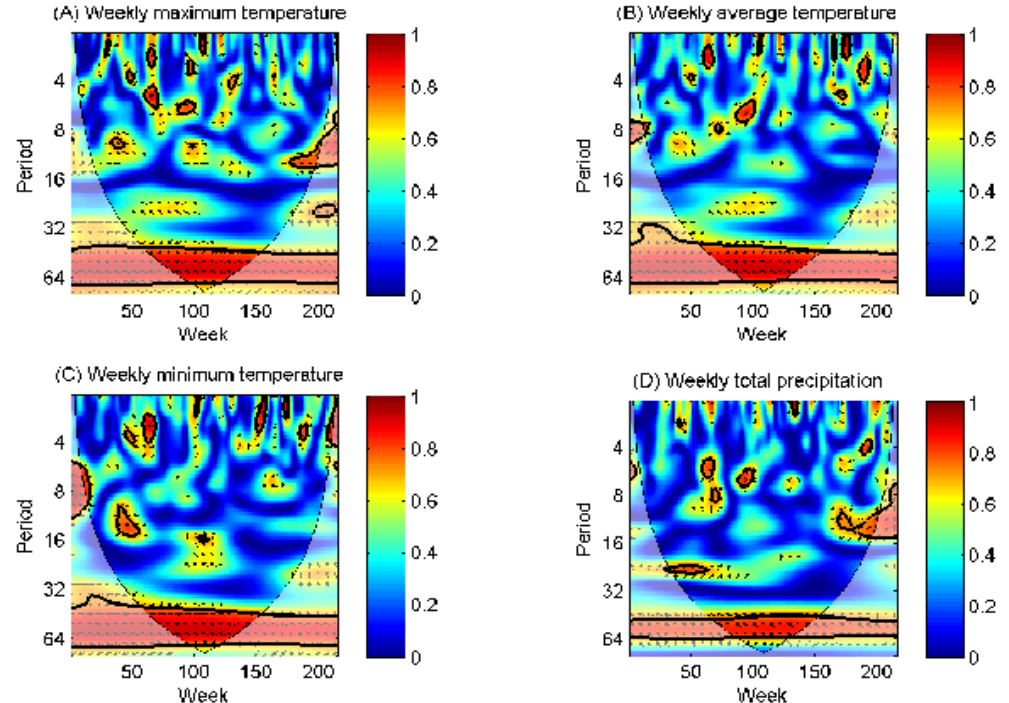
Figure 3. The wavelet coherence between weekly reported human cases of A(H7N9). ( A ) Weekly maximum temperature; ( B ) weekly average temperature; ( C ) weekly minimum temperature; and ( D ) weekly total precipitation for Zhejiang province.